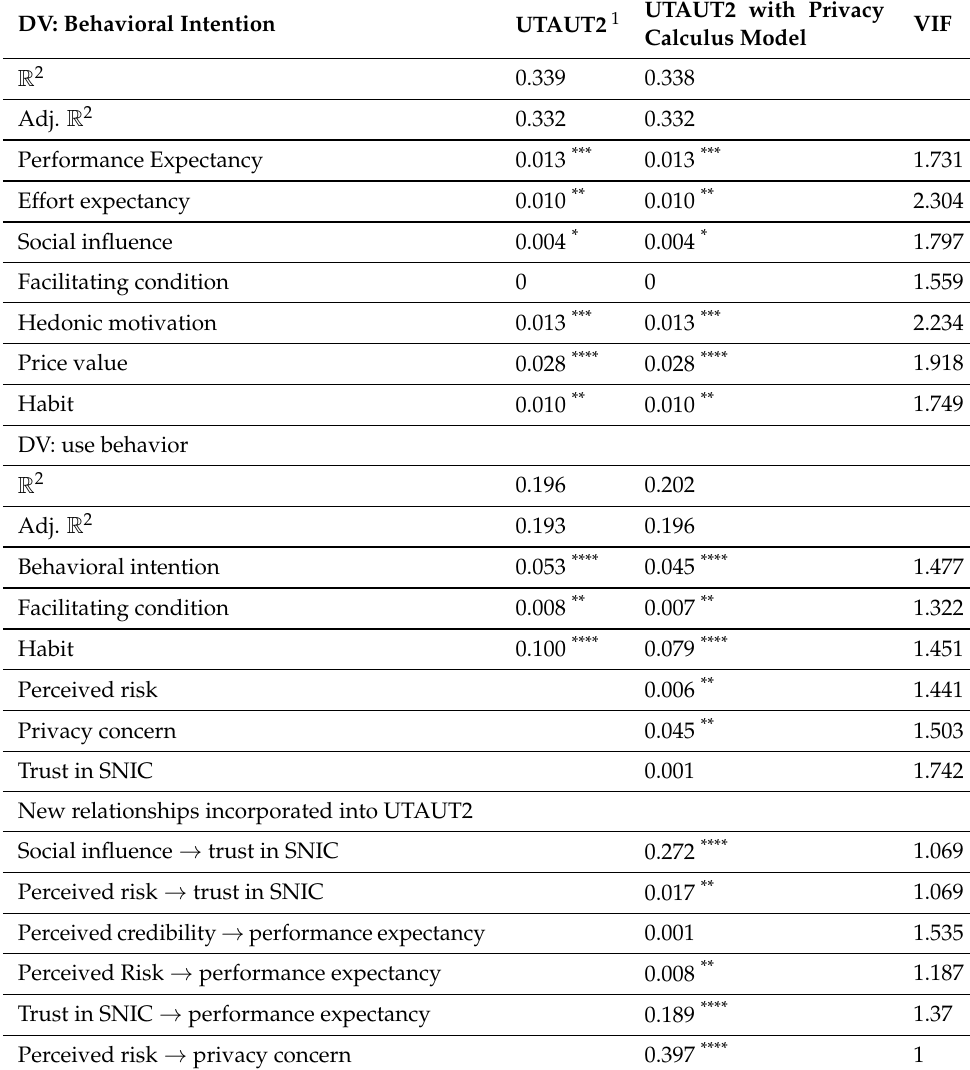
Table 4. Structural model results: UTA2 and UTAUT2 with the privacy calculus